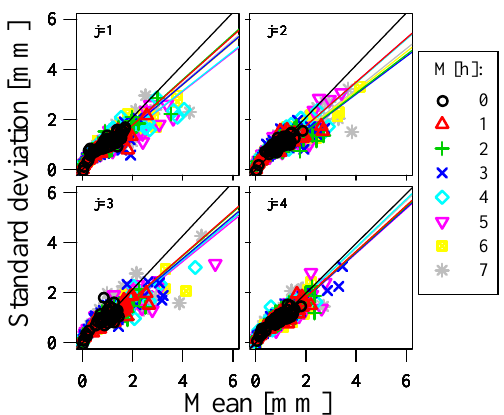
Fig. 10. Sensitivity analysis. Scatter plot of ˆ µ T,j and ˆ σ T,j with fit- ted coefficients of variations (CV T ) for four ensemble realisations, an advection speed of 6kmh − 1 and a catchment area of 4900km 2 . Different points in each panel are for individual points (pixels) of the catchment.